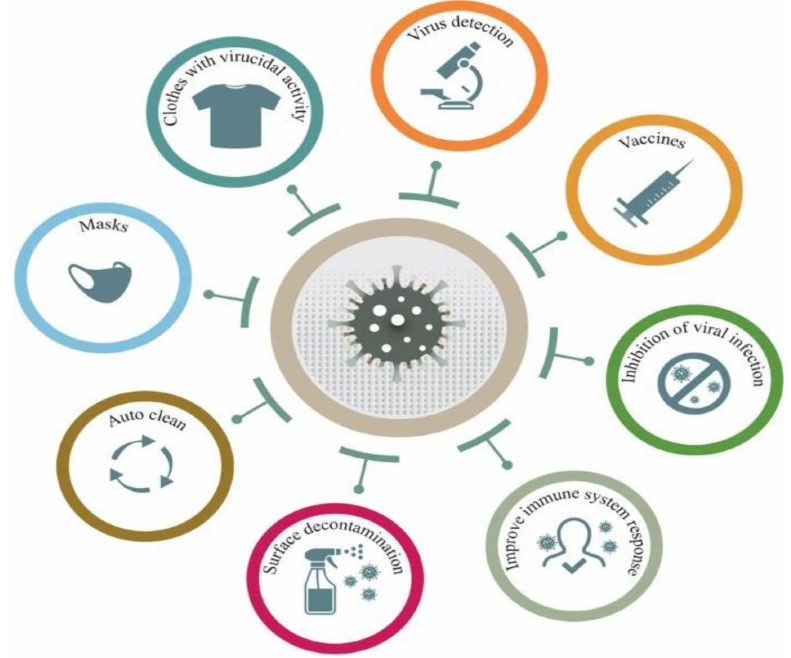
Figure 1. Biomedical applications of nanomaterials against the COVID-19 pandemic. Reproduced with permission [7] under a Creative Commons Attribution 4.0 International